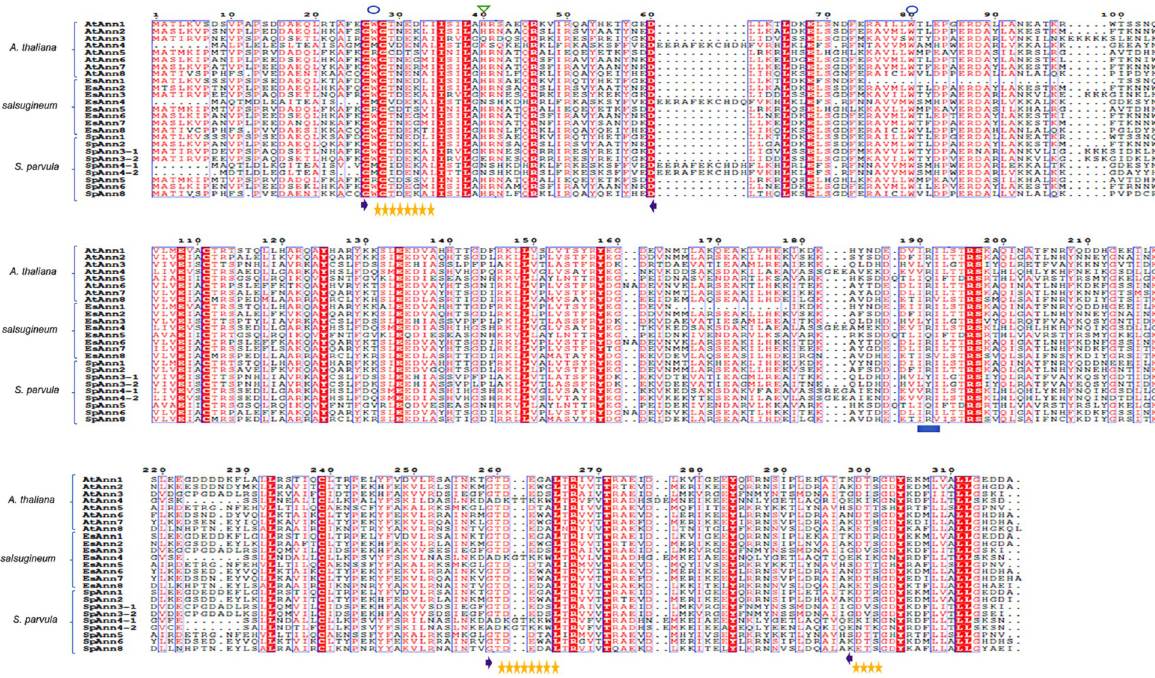
Fig 3. MSA of Ann deduced amino acid obtained by ClustalW in A . thaliana , S . parvula and E . salsugineum . Sequence shading: similarity across groups: blue box; similarity in a group: red box and red character; strict identity: red box and white character. Features: GXGT-38-D/E Ca 2 + -binding sites: purple arrows; conserved tryptophan required for membrane binding: blue circle; His40 key peroxidase residue: green triangle; DXXG putative GTP-binding motif: yellow stars; IRI actin binding motif: blue squares.